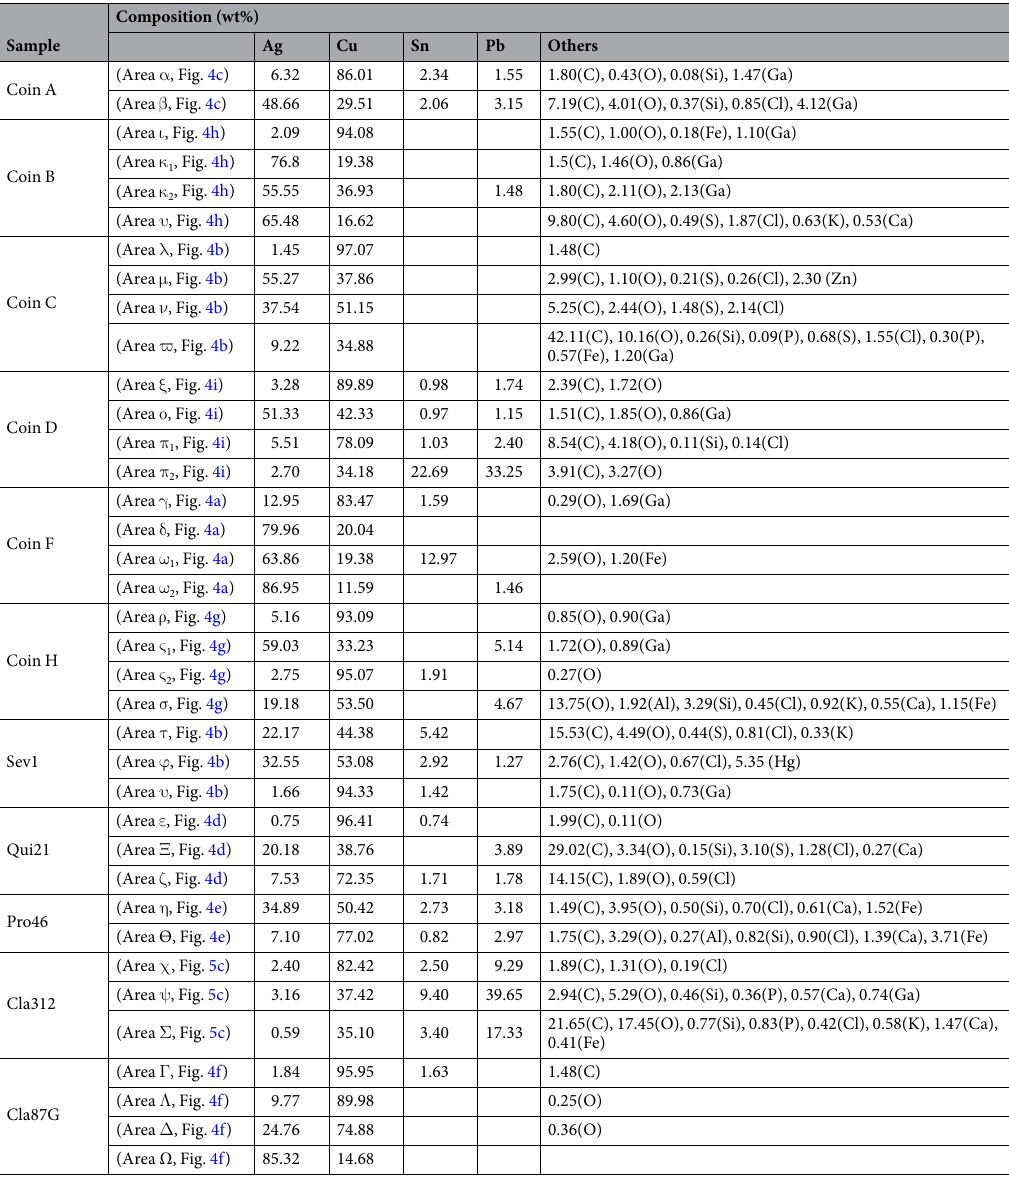
Table 1. Elemental composition obtained from EDS point and area analysis performed in specific layers and phases of the cross-section, 10 μ m deep, provided by the FIB-FESEM trenches on the most representative Antoninianus silver